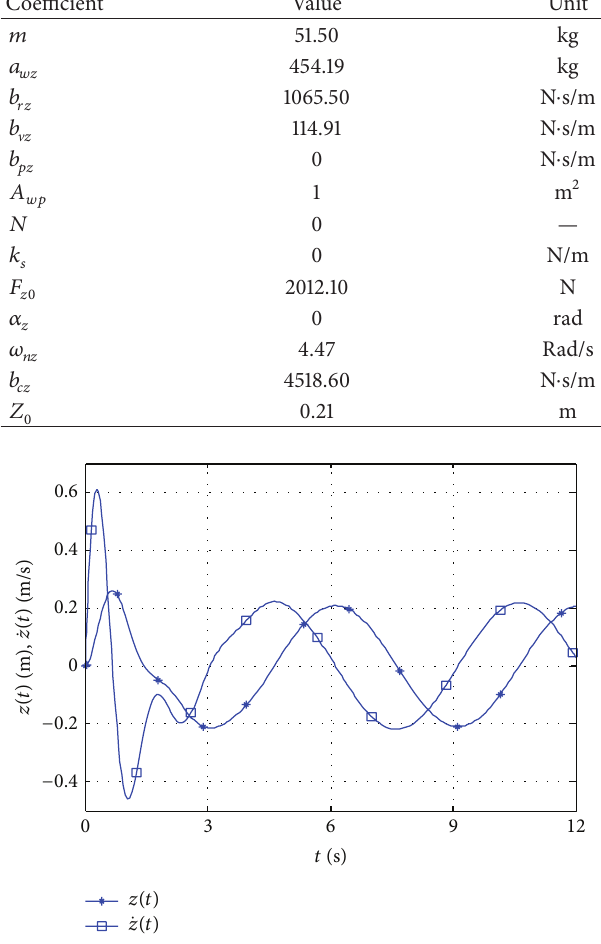
Figure 5: Motion of the conventional heaving